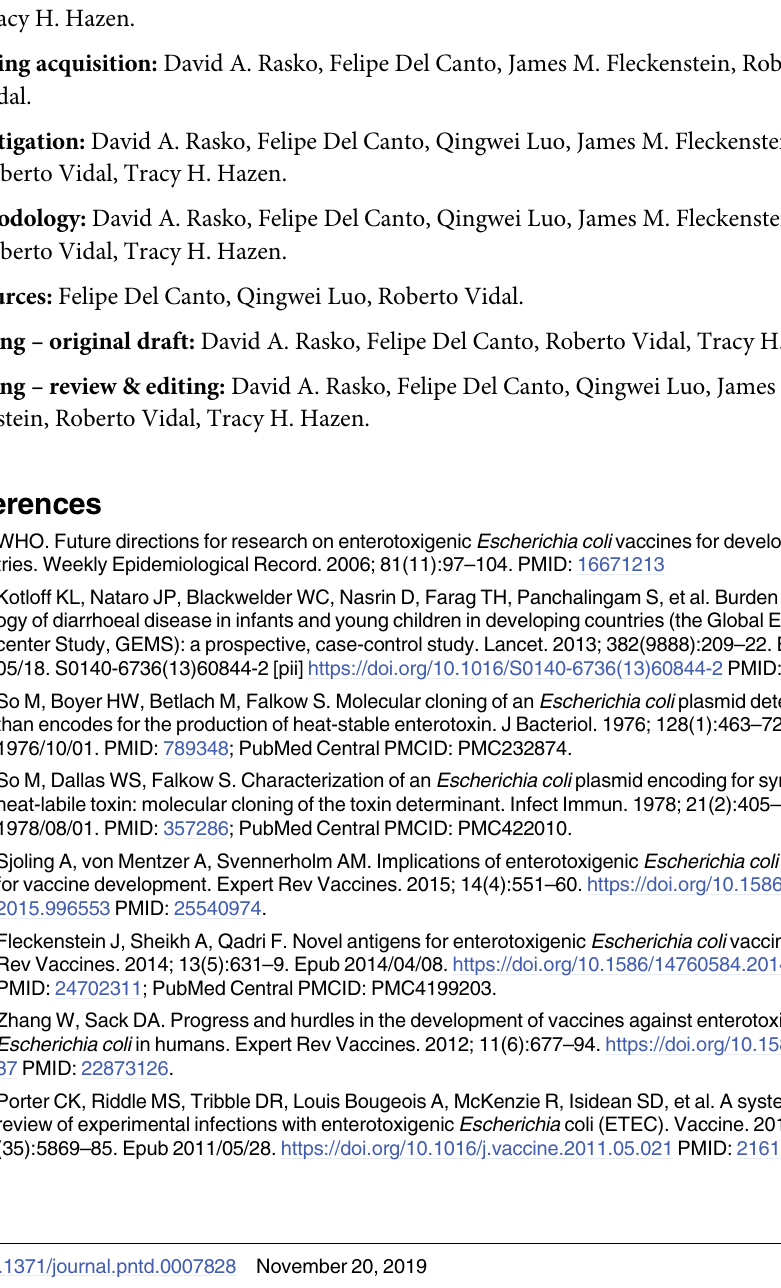
S4 Table. Distribution by geography. S5 Table. Distribution by